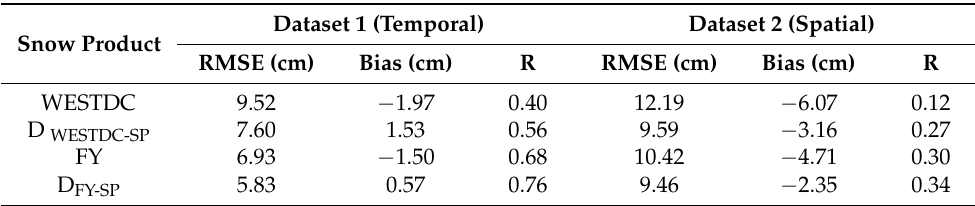
Table 4. Error statistics for the comparison between different SD products and observed SD in this